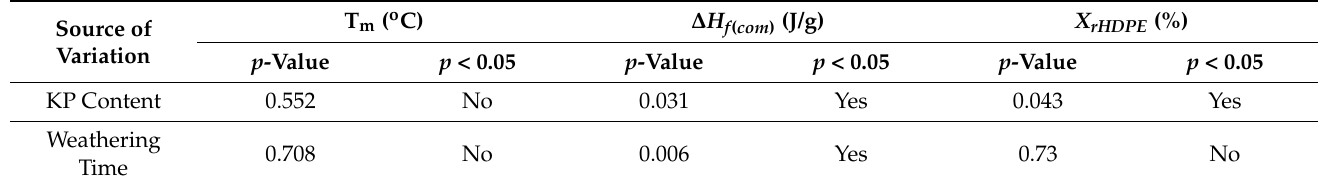
Table 4. The p -value obtained from statistical analysis of KP-filled rHDPE/NR blends before and after 6 and 12 months of natural